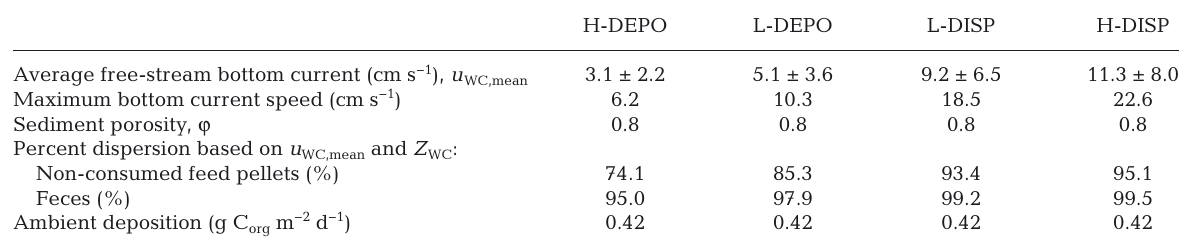
Table 3. Hydrodynamic and sedimentary parameters for scenario analysis. H-DEPO and L-DEPO: high and low deposition; L-DISP and H-DISP: low and high dispersion; Z WC : water column depth below the fish cage; C org : organic